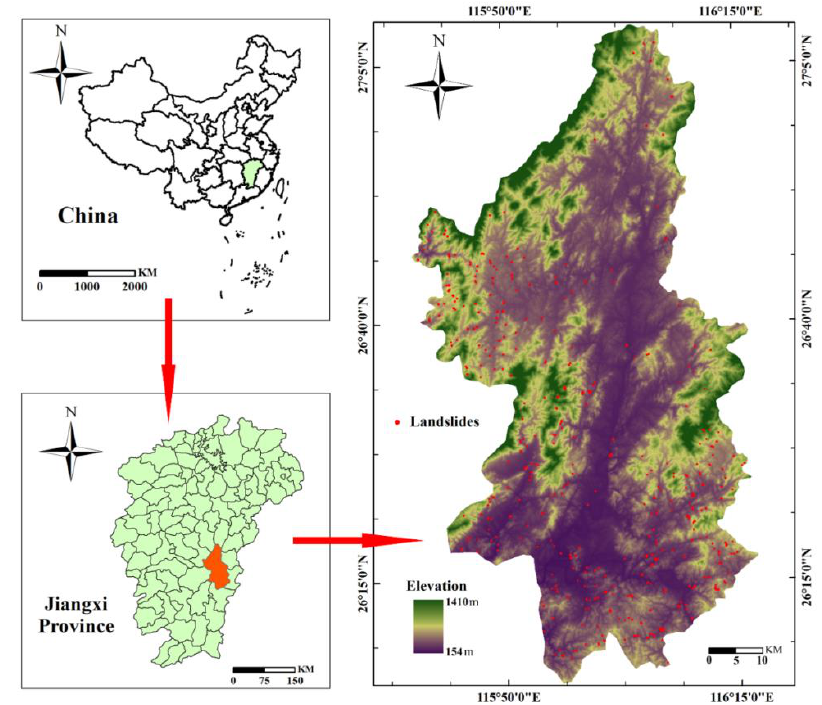
Figure 1. The location and elevation map of Ningdu County.